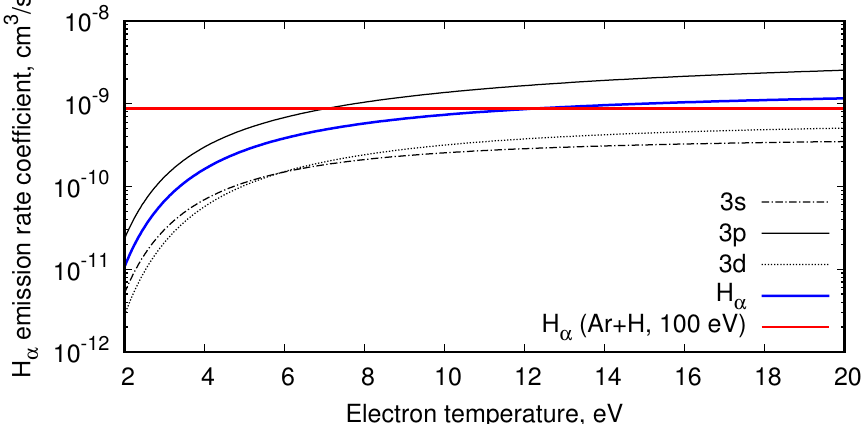
Figure 3. Emission rate coefficient of the Balmer- α line as a function of electron temperature. The electron impact l -resolved excitation rate coefficients κ nl , where n is the principal and l is the orbital quantum number, were obtained by fitting and Maxwellian averaging of cross-sections from close-coupling calculations [15]. The thick red line shows the value of rate coefficients in the case of H-Ar collision at the energy of H atoms of 100 eV; the thick blue line shows the emission rate coefficient due to electron impact according to (7). The thermal motion of Ar atoms was neglected here. The redistribution among the l levels must increase the electron emission rate and decrease the emission rate induced by Ar or Kr.